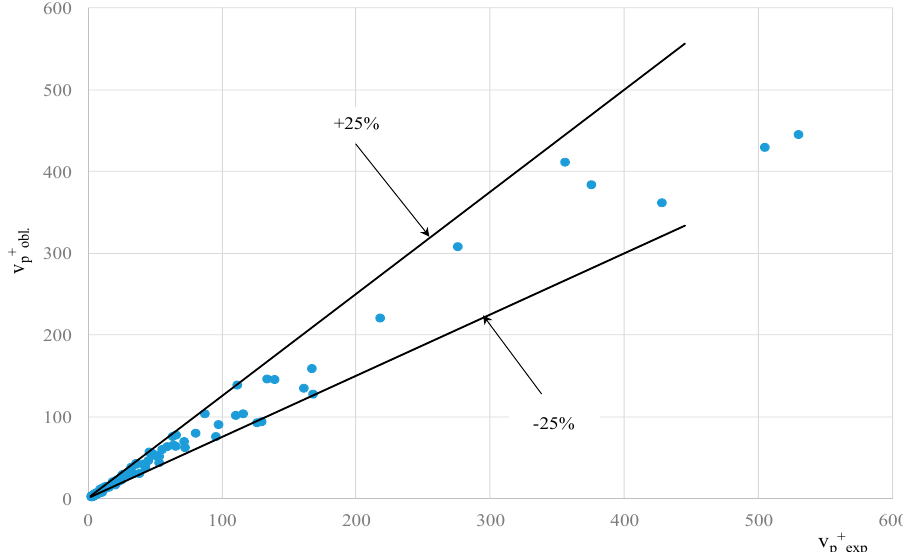
+ v . obtained by dimensional analysis on the regp + v for R134a. exp. p